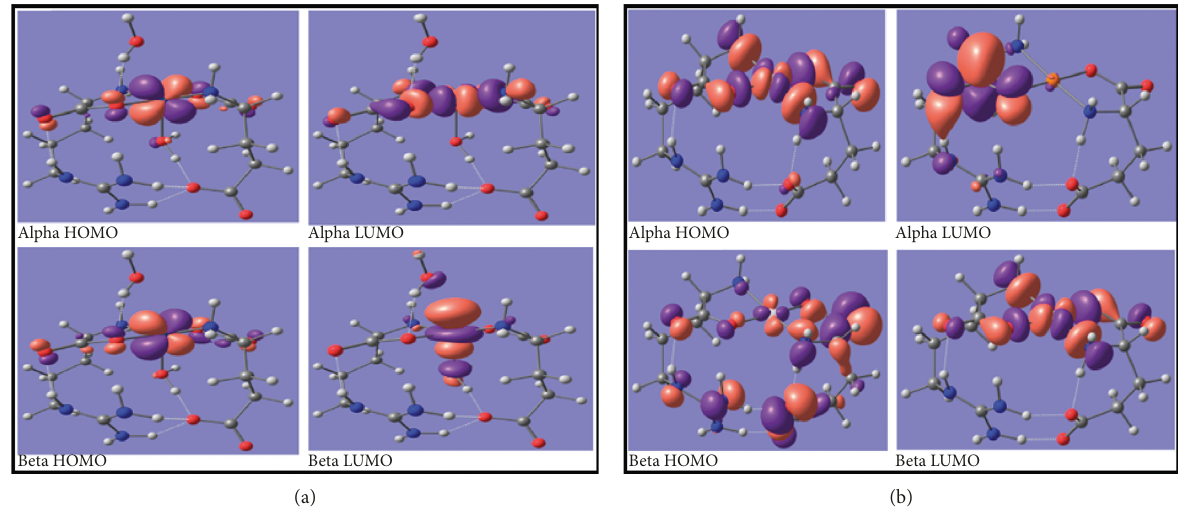
Figure 5: Frontier MOs of (a) Co(II) complex and (b) Cu(II) complex involved in the longest wavelength electronic transition. Surfaces similar to that of Co complex are obtained in case of Ni. There are no d-d transitions in Zn